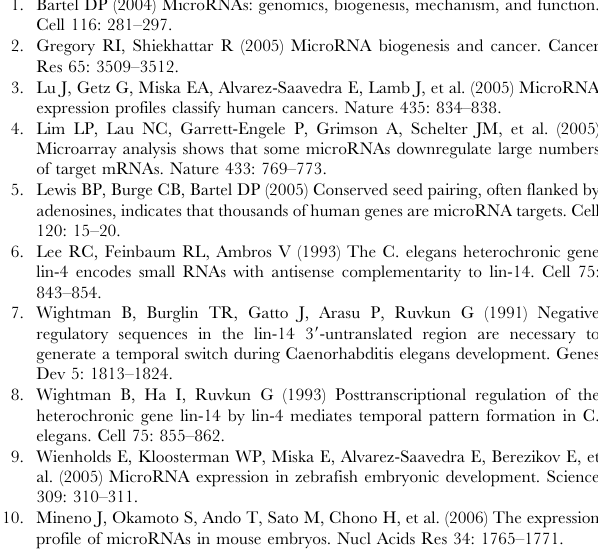
Table S5 Comparative marker selection analysis on 2-cell embryos vs. 4-cell embryos. Only SNR scores of . 0.5 or , 0.5 are shown. Table S6 Comparative marker selection analysis on 4-cell embryos vs. 8-cell embryos. Only SNR scores of . 0.5 or , 0.5 are shown. Table S7 Comparative marker selection analysis on 8-cell vs. morula. Only SNR scores of . 0.5 or , 0.5 are shown. DOC) Table S8 Comparative marker selection analysis on morula vs. blastocyst. Only SNR scores of . 0.5 or , 0.5 are shown. Table S9 Comparative marker selection analysis on 8-cell vs. blastocyst. Only SNR scores . 0.5 or ,2 0.5 are shown. Table S10 Predicted target genes using (miRBASE)for candi- date miRNAs involved in trophectoderm specification were classified by gene ontology. Pathways with p , 0.05 are